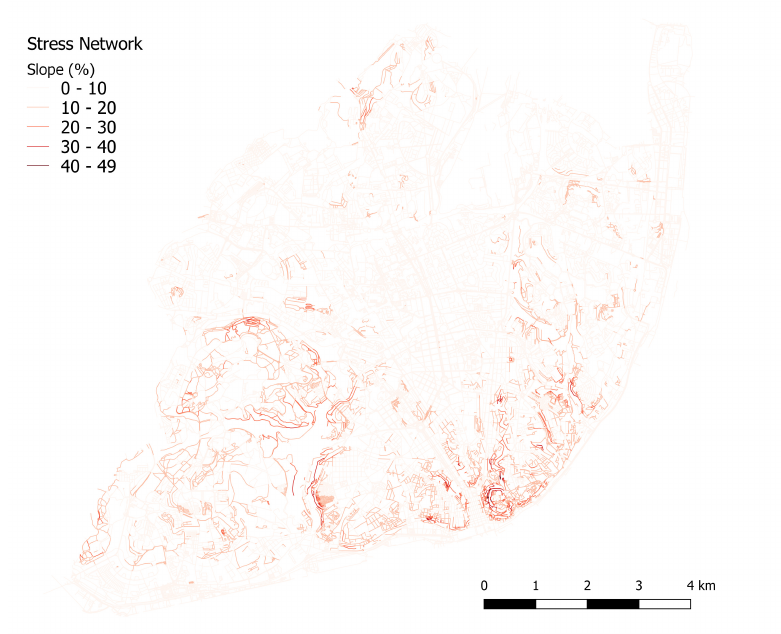
Figure A2. Slope percentage for the stress network in